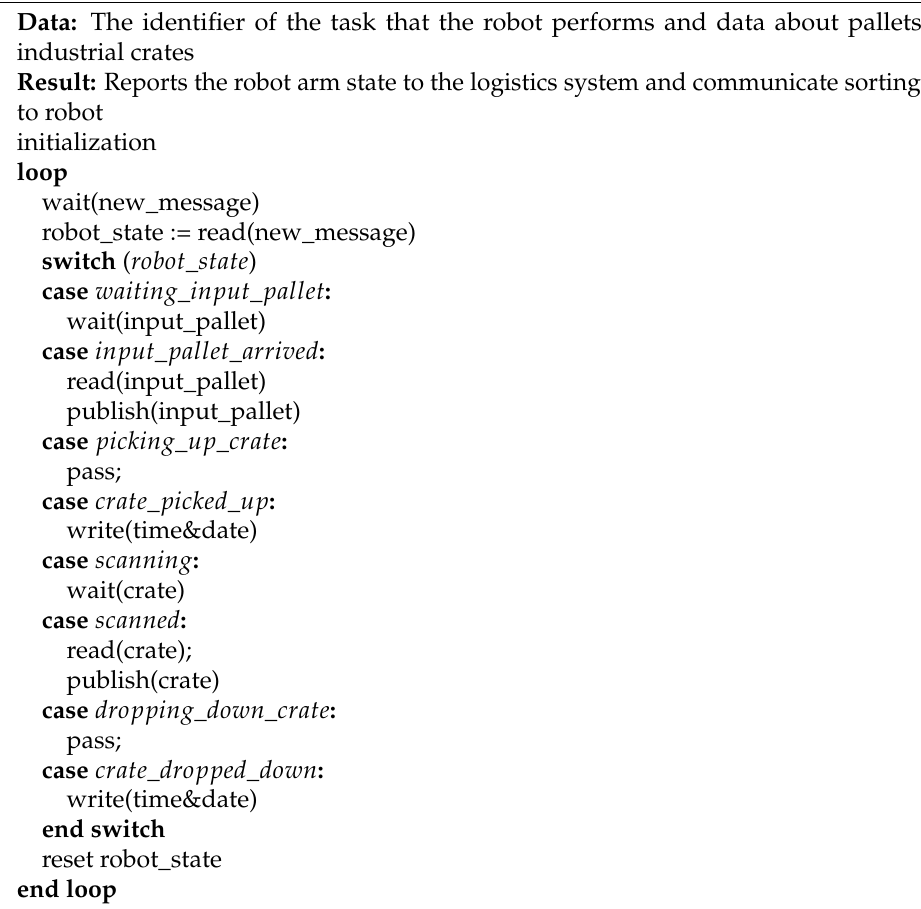
Algorithm 3 Communication with OPIL